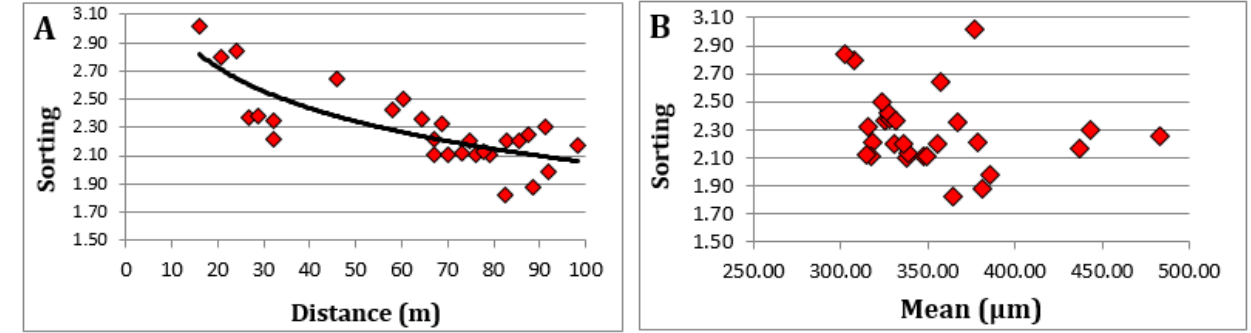
Figure 5. ( A ) Variation of sand sorting with respect to the distance from the landside to the beach, showing a clear decrease (better classification) in the samples located in the primary and embryonic dunes. ( B ) Graph of the relationship between mean size and sorting of the sand grains, giving no correlation between the two parameters.